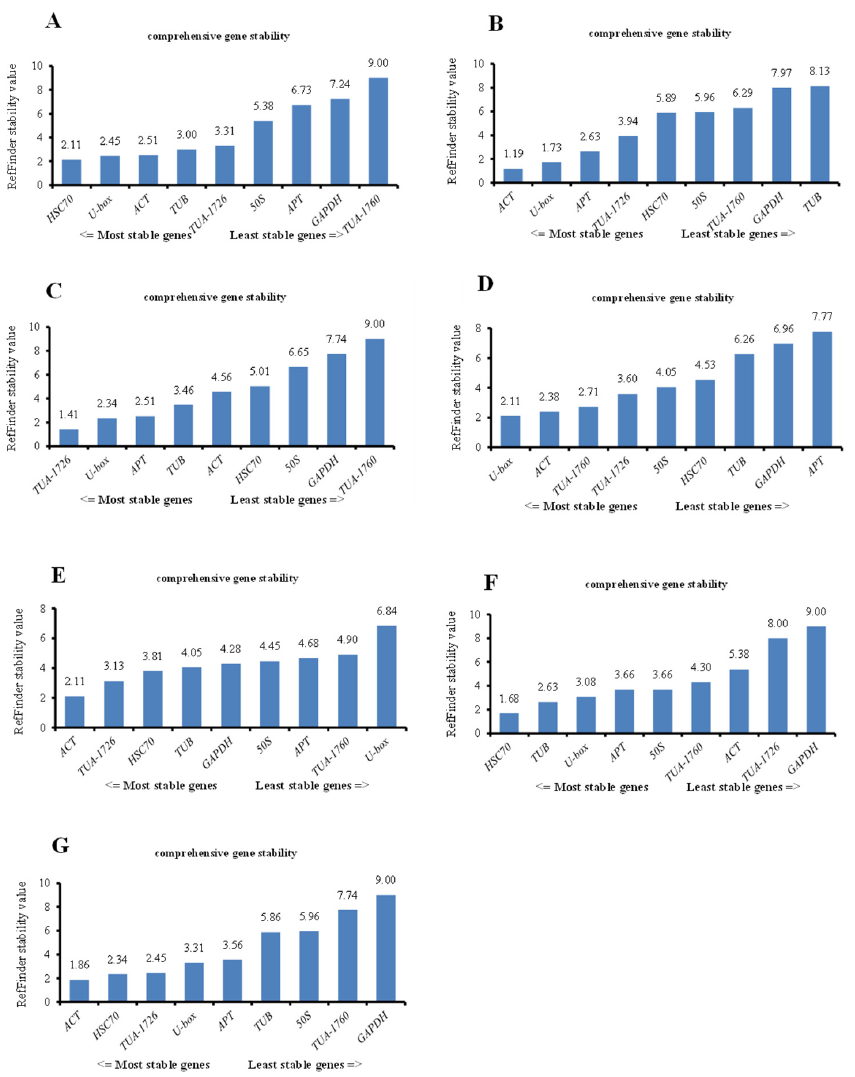
Figure 5. Stability ranking of all reference genes in different treatments of S. ferganica calculated by the RefFinder in all samples. ( A ) Internal reference genes in the ABA treatment group. ( B ) Internal reference genes in heat-treated samples. ( C ) Stability ranking of internal reference genes in all samples treated with cold. ( D ) Internal reference genes from NaCl-treated samples. ( E ) Reference genes derived from MV. ( F ) PEG-treated samples representing drought treatment. ( G ) All samples used in this